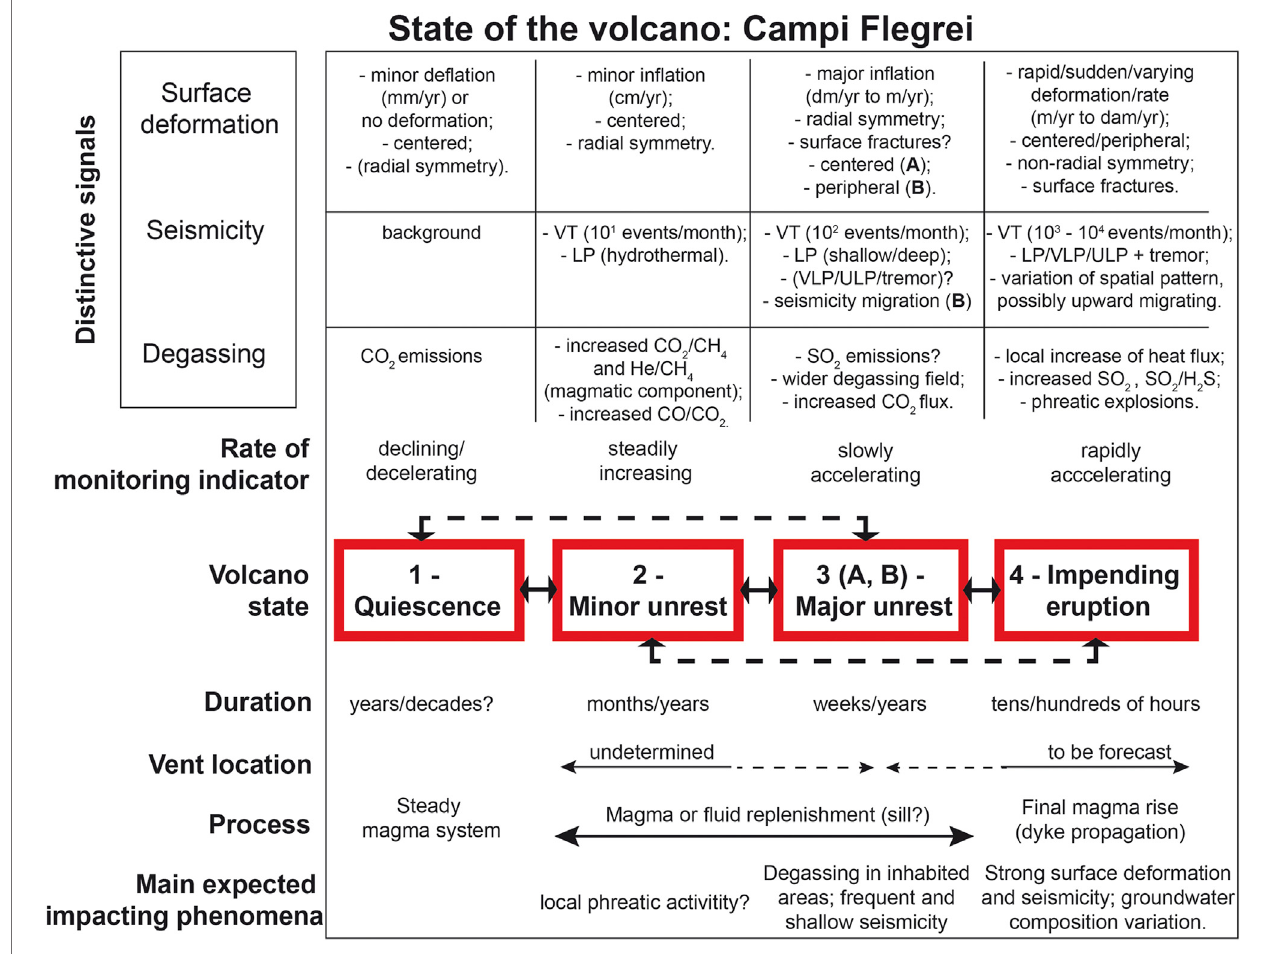
FIGURE4| StatesproposedforCampiFlegreicalderaandrelatedparameters.Thereportedvaluesofthemonitoringparameterssuggestthemostlikelyorder(s)of magnitude for a parameter in each state, although a speci fi c state may be accompanied by a different order of magnitude. The most likely rate associated with the monitoring parameters in each state (in terms of deceleration, steady increase, slow or rapid acceleration) is also suggested.